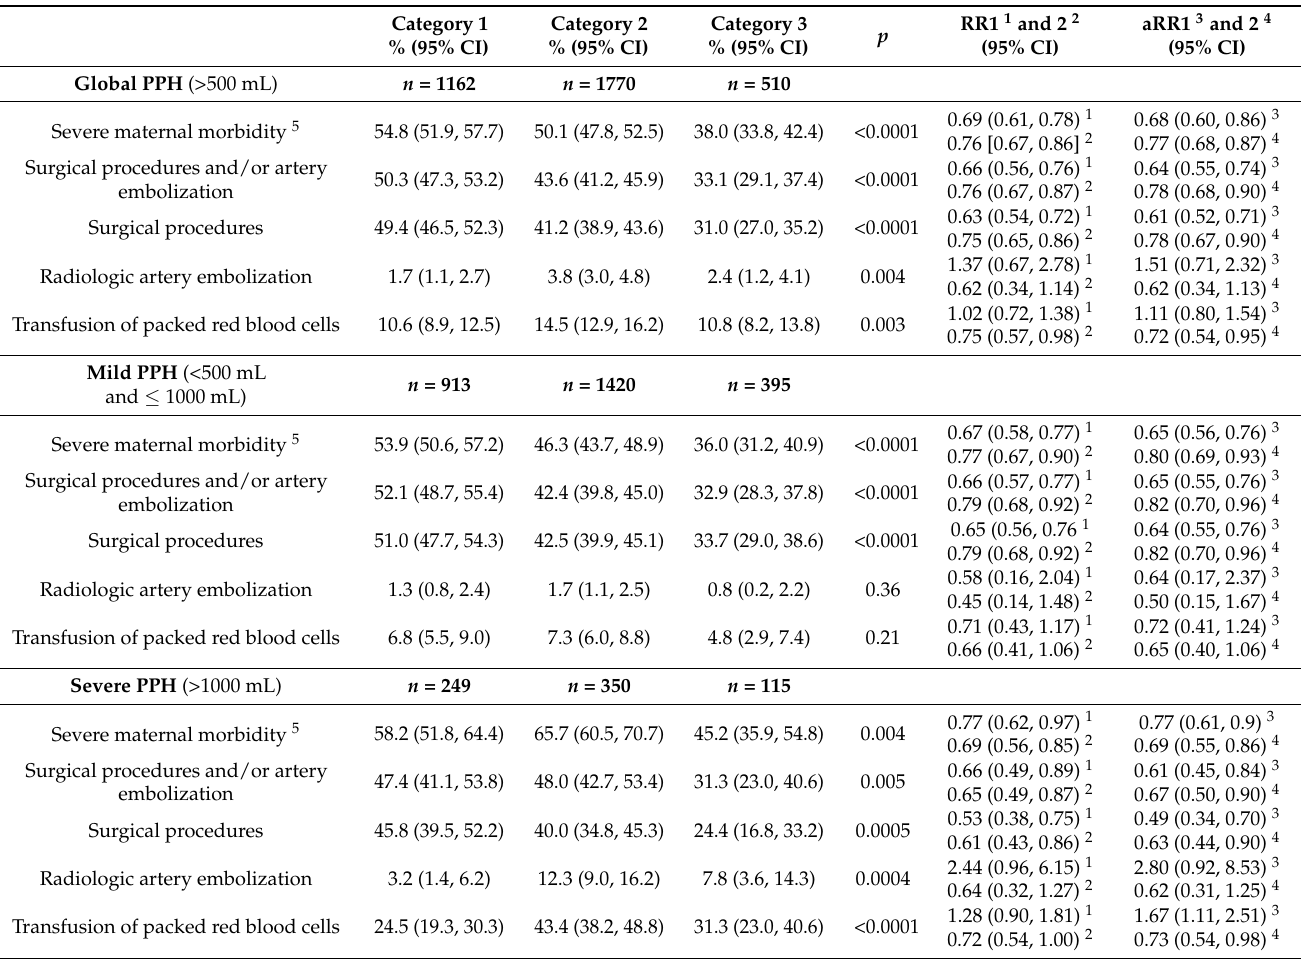
Table 4. Incidences and risks of second-line treatments according to protocol-quality category and PPH severity (global, mild, and severe).